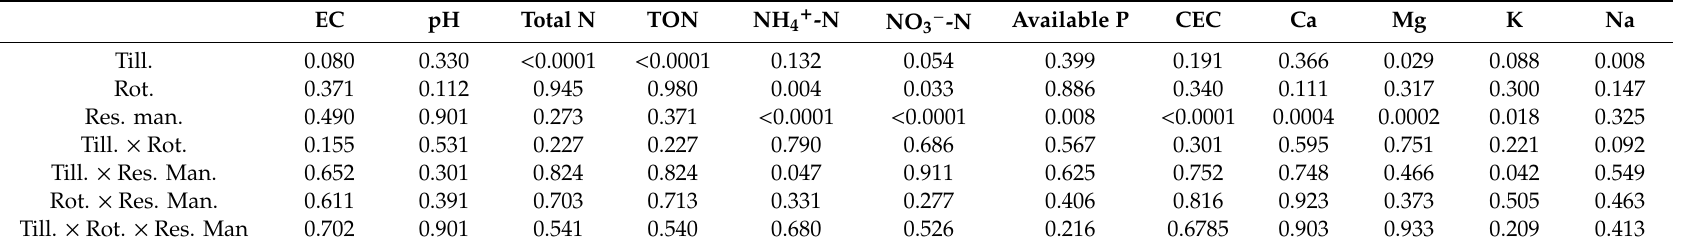
Table 2. Analysis of variance (ANOVA) results of electrical conductivity (EC), pH, total nitrogen, total organic nitrogen (TON), ammonium (NH 4 + -N), nitrate (NO 3 − -N), available phosphorus (available P), cation exchange capacity (CEC), calcium (Ca), magnesium (Mg), potassium (K) and sodium (Na) as influenced by tillage, rotation, crop residue management and their interaction. EC pH Total N TON NH 4 + -N NO 3 − -N Available P Ca Mg K Na Till. Res. man. Till. × Rot. Till. × Res. Man. Rot. × Res. Man. Till. × Rot. × Res. Man Till.: tillage; Rot.: Rotation; Res. Man.: crop residue